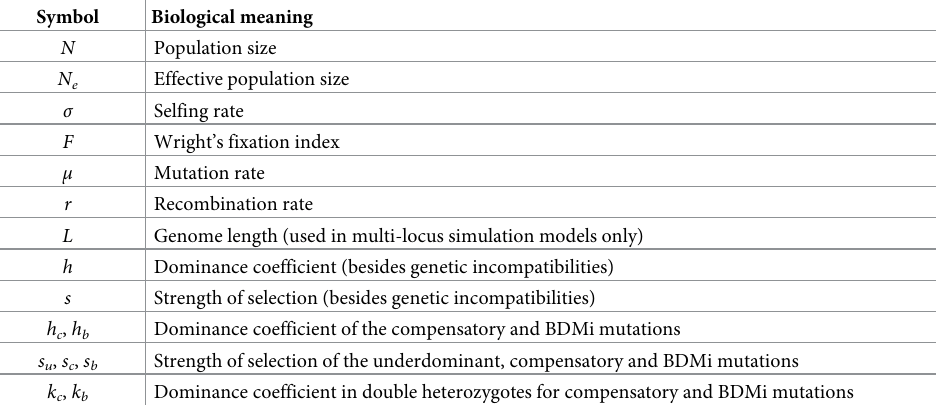
Table 1. Glossary of the main